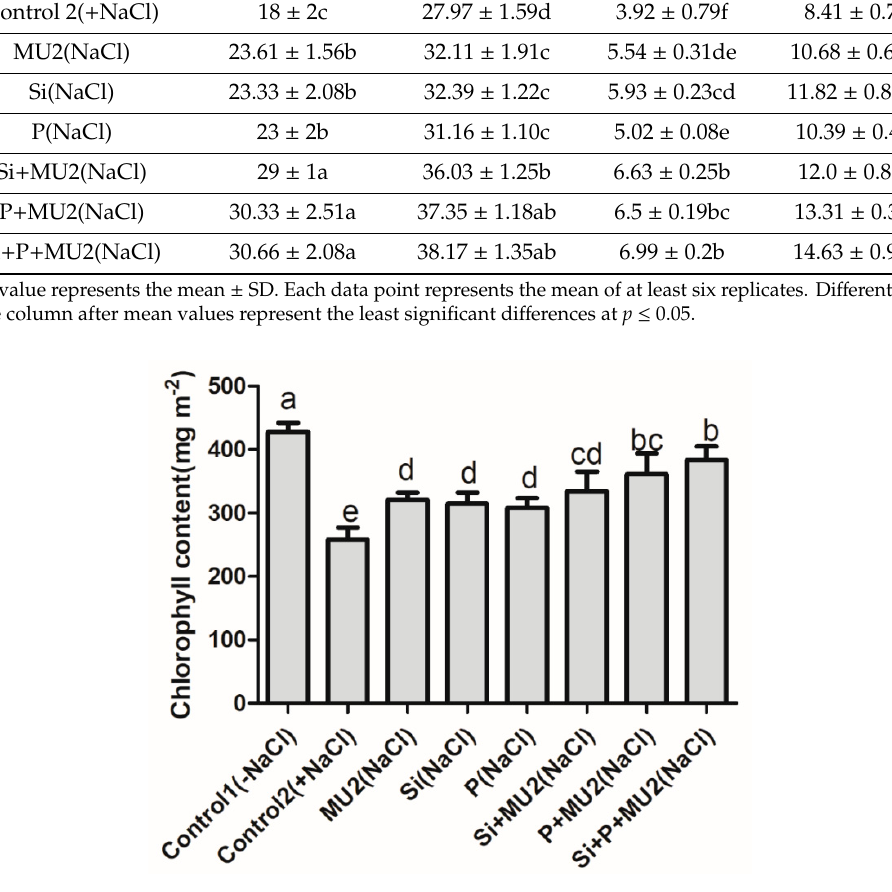
Table 4. E ff ects of P. koreensis MU2 inoculation on plant growth promoting attributes of soybean plant under salt stress. Treatments Root Length Shoot Length Root Wt. Shoot Wt. Each value represents the mean ± SD. Each data point represents the mean of at least six replicates. Different letters in the column after mean values represent the least significant differences at p ≤ 0.05.